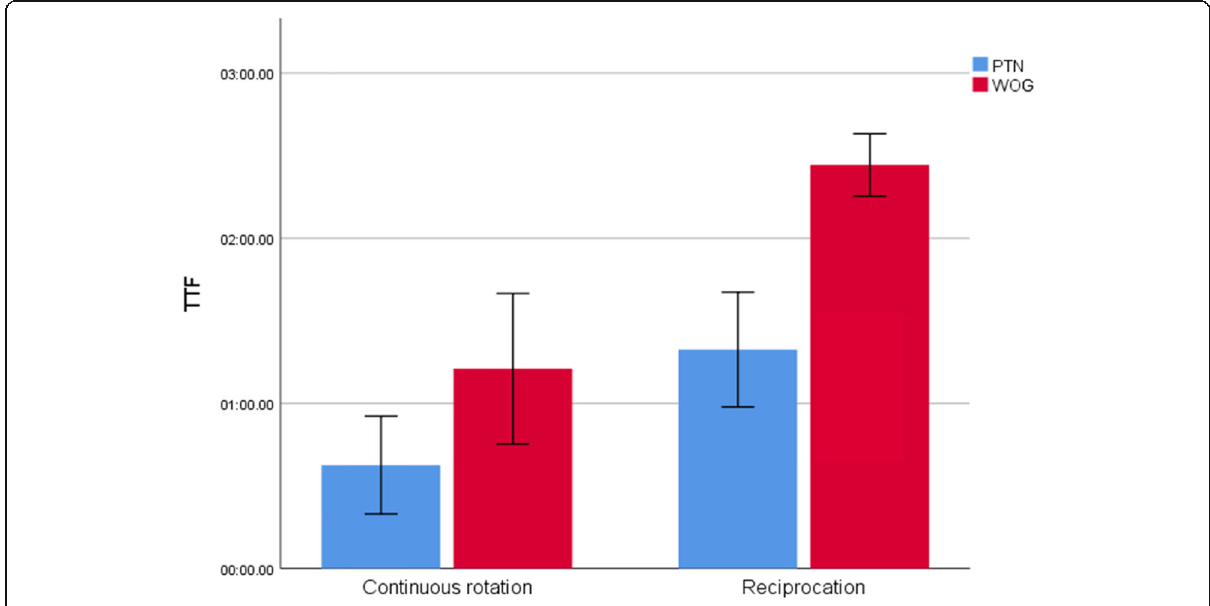
Fig. 2 Bar chart showing mean and standard deviation values of time till fracture (TTF) (mm:ss:ss) in different groups